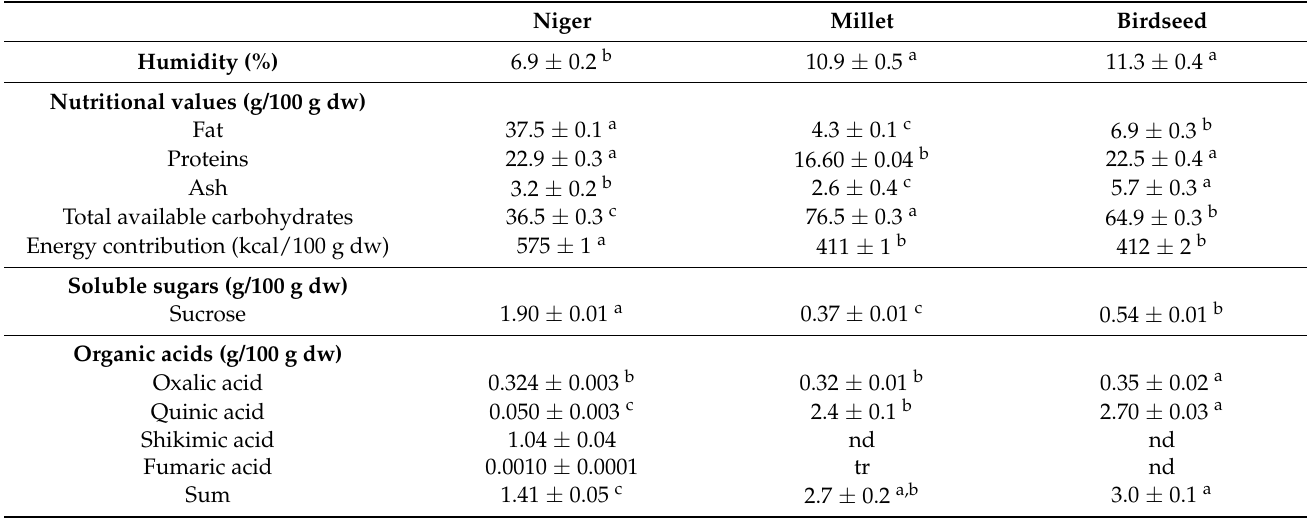
Table 3. Proximate composition, soluble sugars and organic acid compositions in niger, millet and birdseed (mean ± SD results expressed on a dry weight